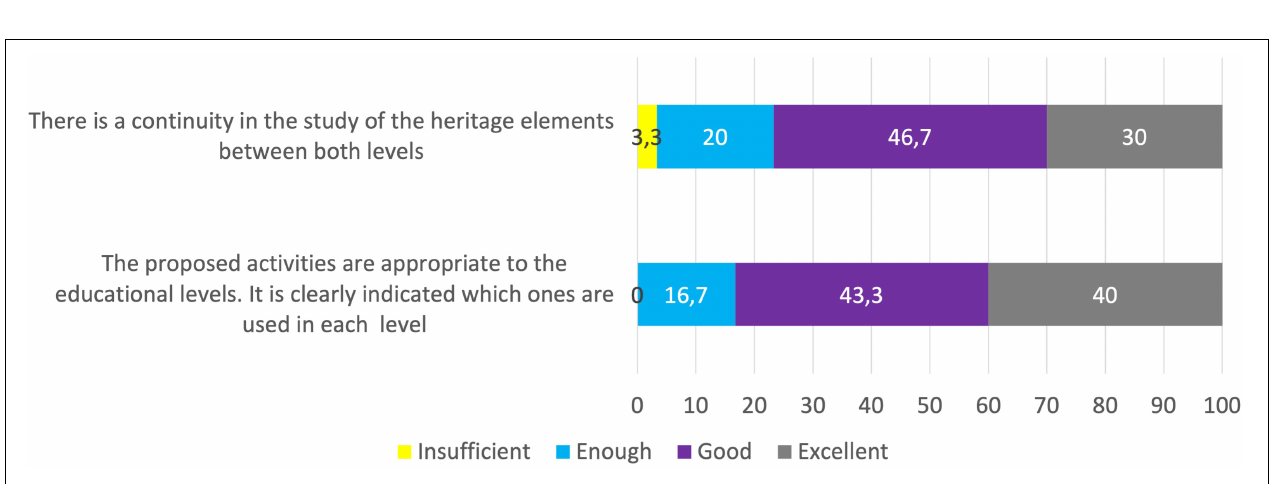
GRAPH 3 | Results of the level of performance according to selected indicators of the rubric.